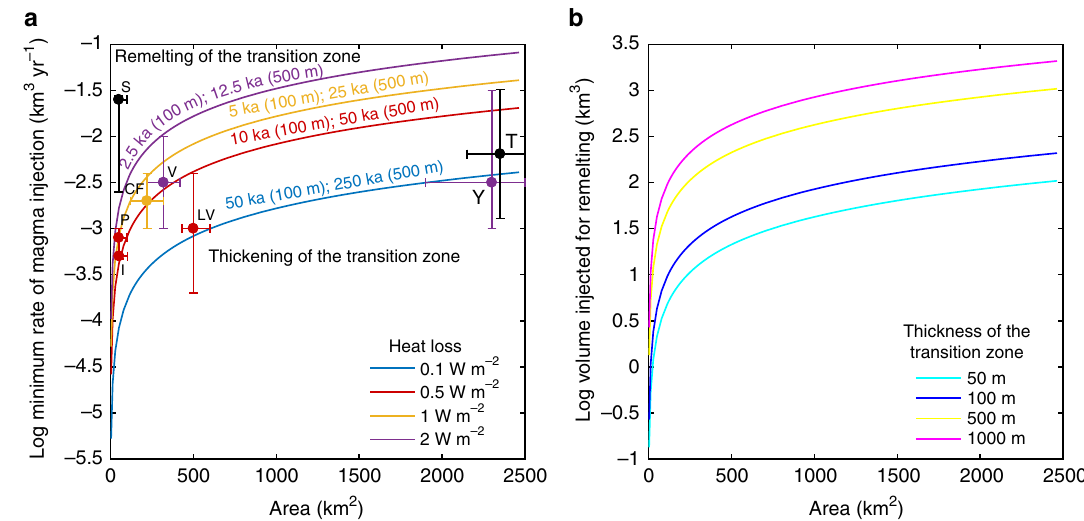
Fig. 3 Thermal stability of the transition zone. Thermal stability of the transition zone in a replenished magma reservoir. a Minimum rate of magma injection required for remelting the transition layer as a function of the roof area of cylindrical reservoirs. The lines show different rates of heat loss per unit area. For lower injection rates, the heat loss is larger than the heat input and the transition layer thickens; for higher injection rates, the transition layer thins. The lines also show the time required for the remelting a transition zone with different thickness (in brackets). Superimposed are the available injection rates and areas of the roof of the magmatic systems from resurgences, with the corresponding errors (which represent the uncertainty of the data); their colours indicate the estimated surface heat fl ow (black indicates lack of information): I Ischia 42,43 , P Pantelleria 4,44 , CF Campi Flegrei 45,46 , S Siwi 15 , V Valles 31,47 , LV Long Valley 7,48 , Y Yellowstone 11,49 , T Toba 13 . b Volume of magma required for remelting transition layers of different thickness (colour lines) as a function of the roof area of cylindrical